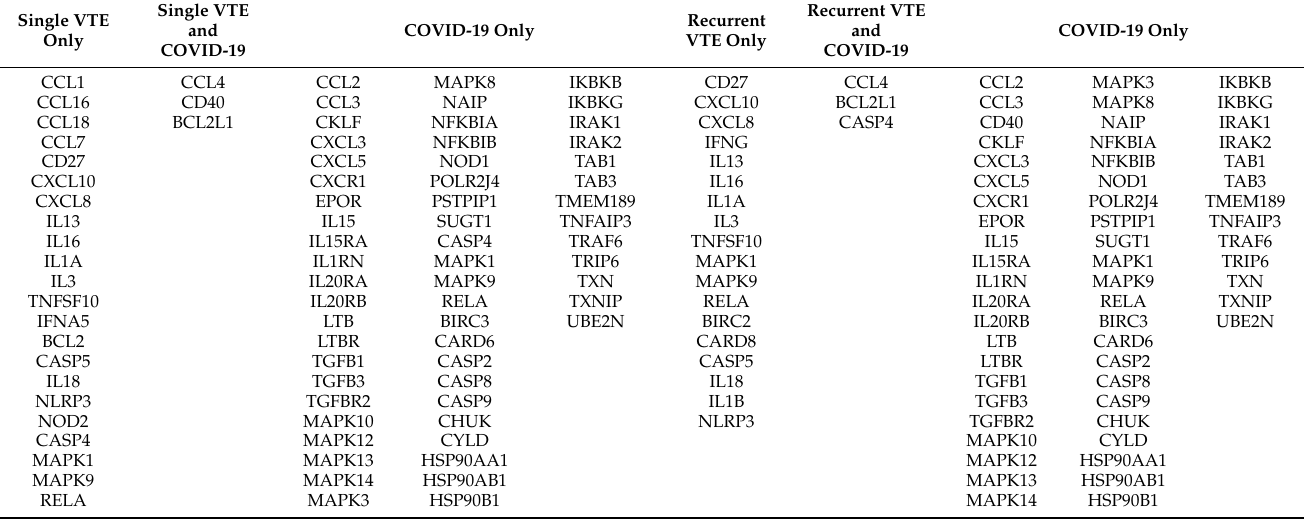
Table A2. Complete list of dysregulated cytokine and inflammasome-related genes. Single VTE Single VTE Only